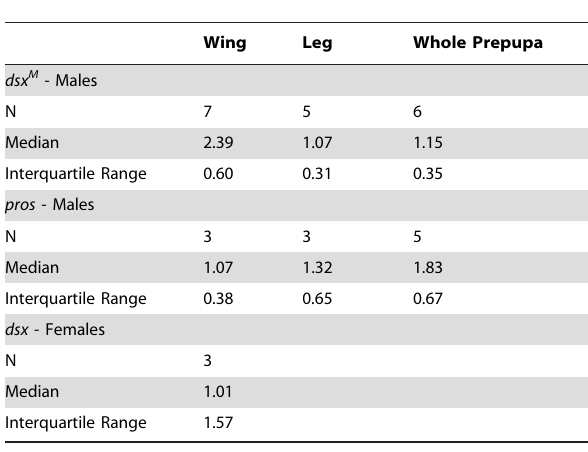
Table 3. Gene expression analysis in the ws1